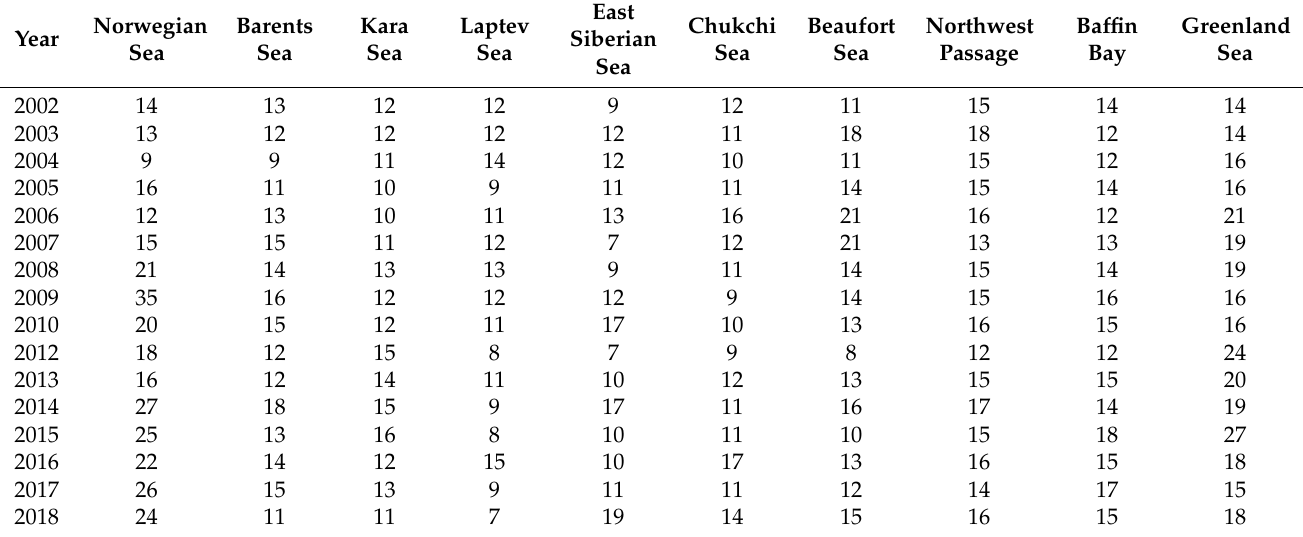
Table 9. Days from freezing up to complete freezing of Arctic sea ice,